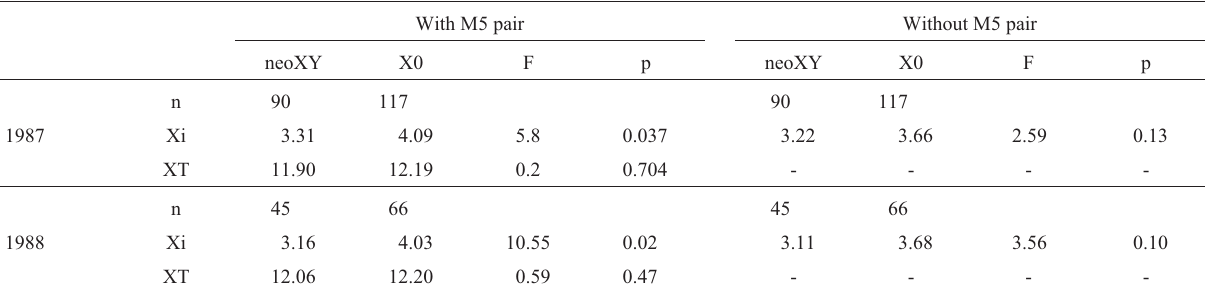
Table 5 - Mean interstitial (Xi) and total (XT) chiasma frequencies from Sinipta dalmani males with different karyomorphs for the M5-X fusion with and without the data of the M5 pair in two samples of the Los Loros population. F: statistic value for the comparison of averages among karyomorphs. (n: number of analyzed